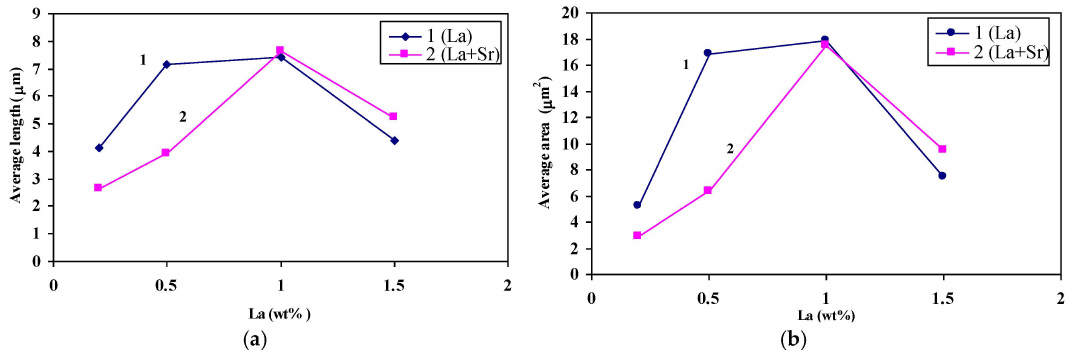
Figure 12. ( a ) The effect of La and Sr on the average of Si particle length; ( b ) the effect of La and Sr on the average of Si particle area.